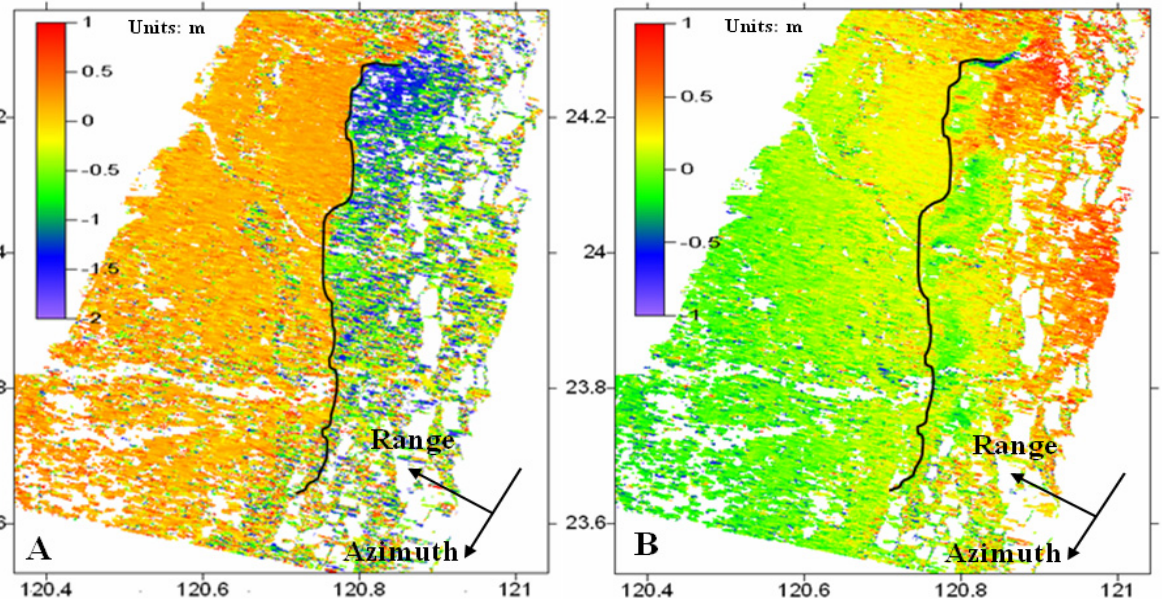
Figure 6. The ground surface displacements in (a) the azimuth and (b) the range directions. The black solid line shows the location of the Chelungpu